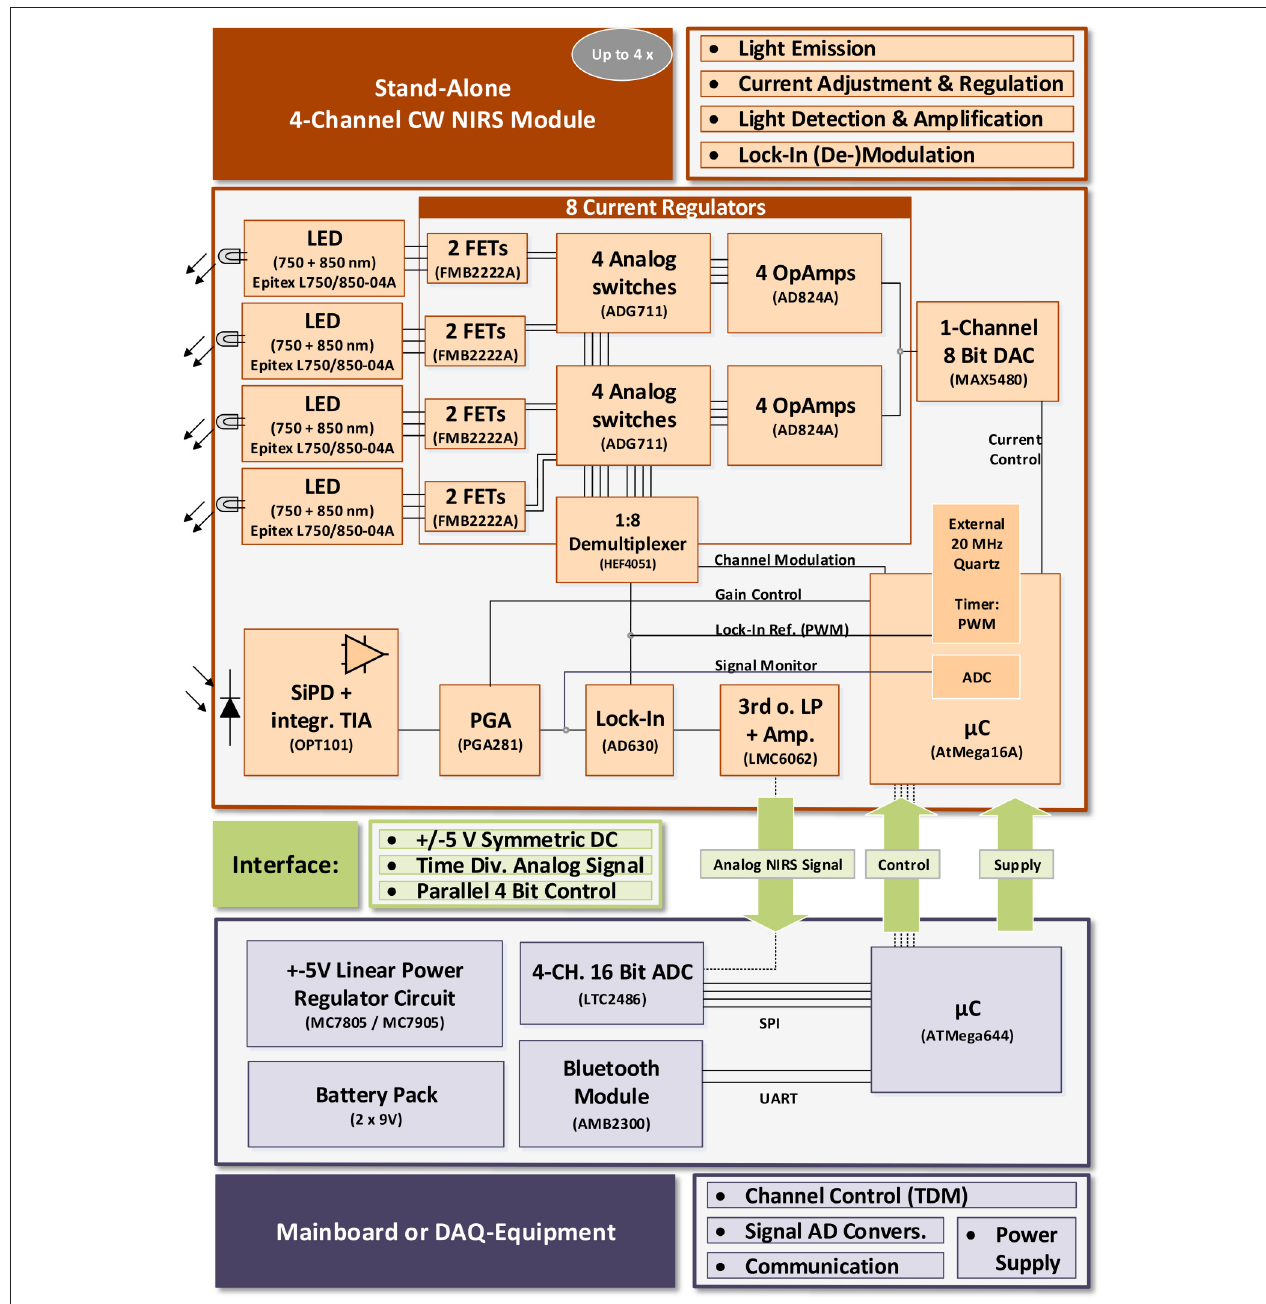
FIGURE 1 | System